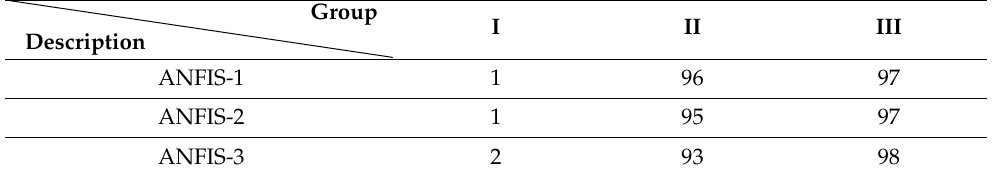
Table 16. Parallel recognition system feature numbers.